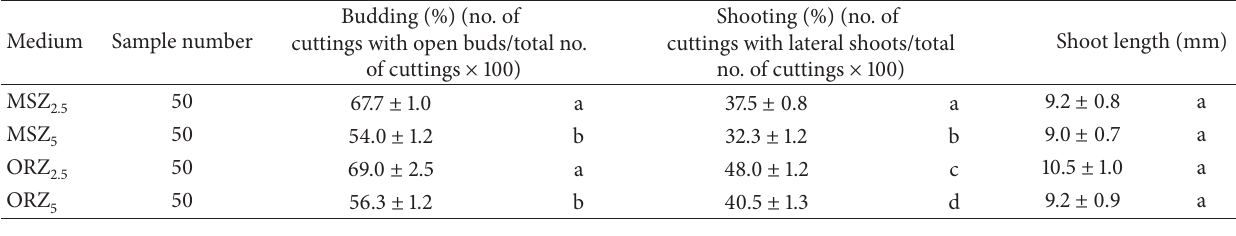
Table 1: Effects of different medium on the vegetative growth of seedling-derived cuttings (Sc MSZ = Murashige and Shoog medium + 2.5 mg/L (11.5 𝜇 M) and 5mg/L (23 𝜇 M) trans - sylvestris after 45 days of in vitro culture. MSZ 2.5 5 ORZ ; olive medium + 2.5 mg/L (11.5 𝜇 M) and 5 mg/L (23 𝜇 M) trans -zeatin, respectively. Means with common zeatin, respectively; ORZ 2.5 2.5